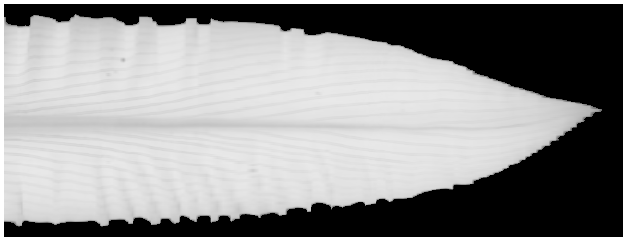
Figure 2. The segmentation result from the raw hyperspectral image. The grey region (plant tissue) was successfully separated from the black region (background).